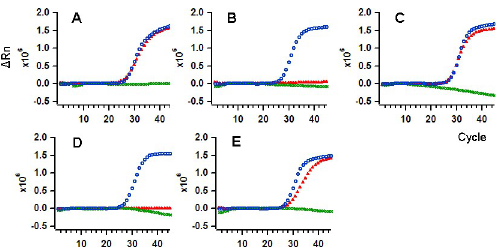
Fig 1. The amplification plot of various sample buffers with DNA polymerases. The amplification plots were obtained using MM4 in combination with K4pol L329A (red, triangle), RTX (green, cross), or M1pol Tth (blue, open circle). Here, 10 4 copies of synthetic RNA were used as the template. The sample buffers used were as follows, A. Buffer 1, B. Buffer 2, C. Buffer 3, D. Buffer 4, and E. Buffer 5.